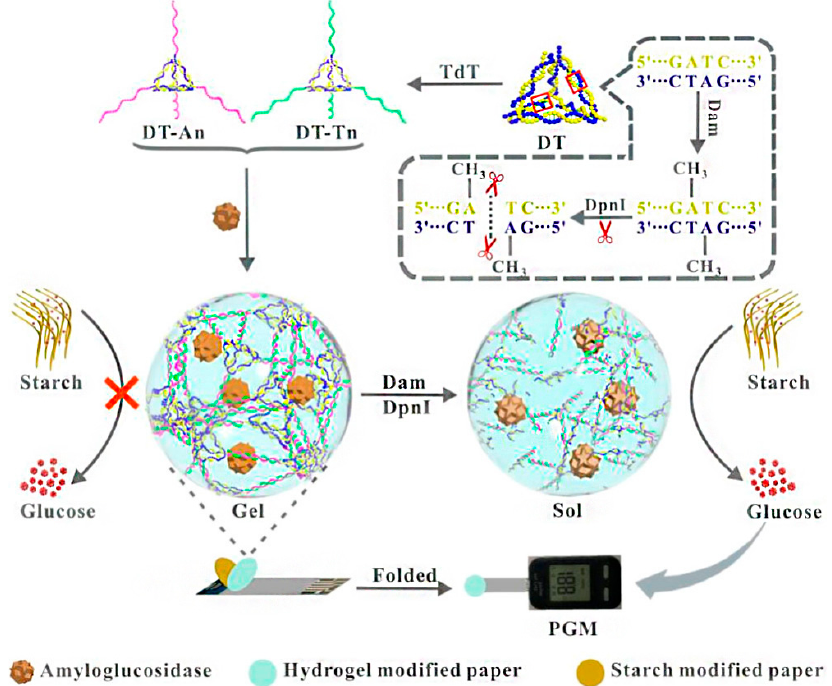
Figure 9. Schematic illustration of POCT tool integrating Dam-responsive DNA tetrahedra-crosslinked hydrogels and its evaluation strategy of Dam activity and quantitative. Reproduced with permission from Xin Gao, Analytical Chemistry; published by American Chemical Society, 2020.